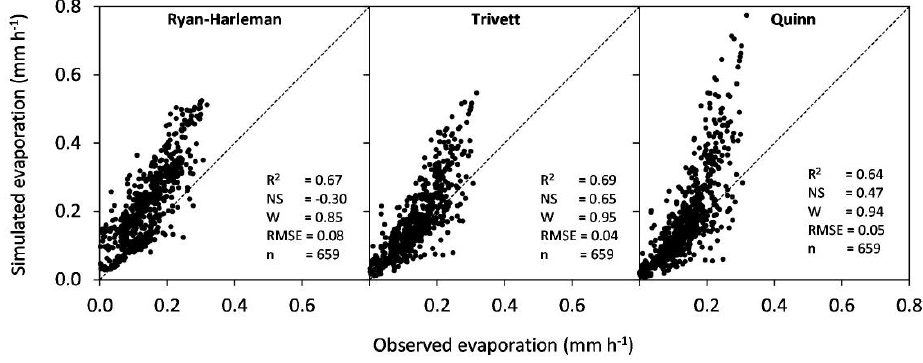
Figure 11. Relationship between measured and estimated E with the equations of the mass transfer group.